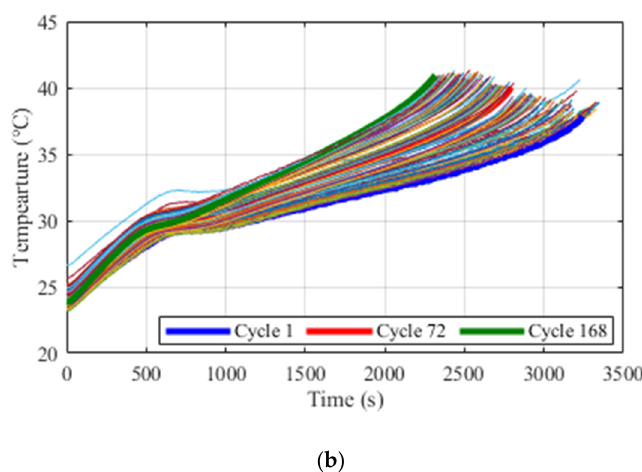
Figure 1. Discharging data profiles at different battery cycles: ( a ) Terminal voltage; ( b ) Battery temperature.